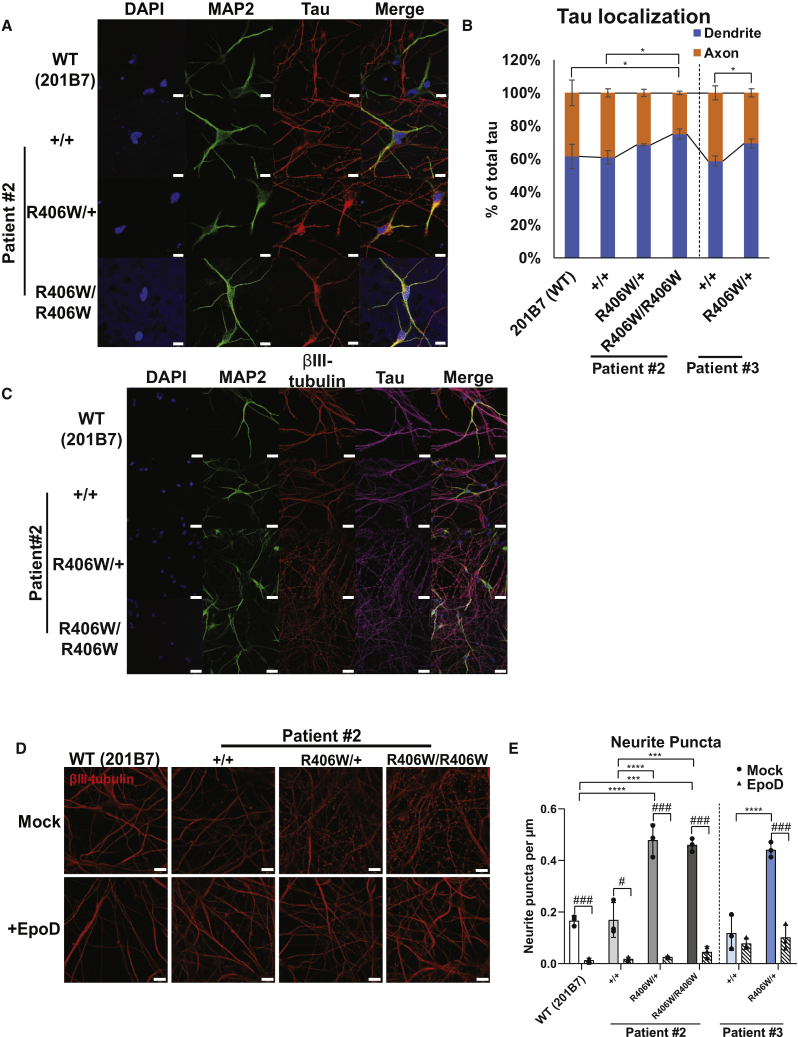
Axonal Phenotypes Caused by MT Destabilization in R406W Mutant Neurons(A and B) Immunostaining of iPSC-derived neurons with MAP2, tau, and DAPI 30 days after dissociation (A). Arrowheads indicate neurons with tau on MAP2+ area. Scale bars, 10 μm. The percentage of tau on the dendrites was significantly increased in the mutant neurons when compared with the control neurons (B) (n = 3 independent experiments, ∗p < 0.05; one-way ANOVA followed by Tukey's test).(C) Immunostaining of iPSC-derived neurons with MAP2, βIII-tubulin, and tau. Scale bars, 20 μm.(D and E) Representative immunofluorescence pictures of βIII-tubulin+ axons with (lower) or without (upper) Epothilone D (EpoD) treatment (D). Scale bars, 10 μm. There was a significantly greater number of puncta in the mutant neurons compared with control neurons, which was rescued with EpoD treatment (E) (n = 3 independent experiments). ∗∗∗p < 0.001, ∗∗∗∗p < 0.0001 when comparing control with R406W mutants; one-way ANOVA followed by Tukey's test. #p < 0.05, ###p < 0.001 when comparing mock with EpoD; Student's t test.Error bars indicate mean ± SEM. See also Figure S5.